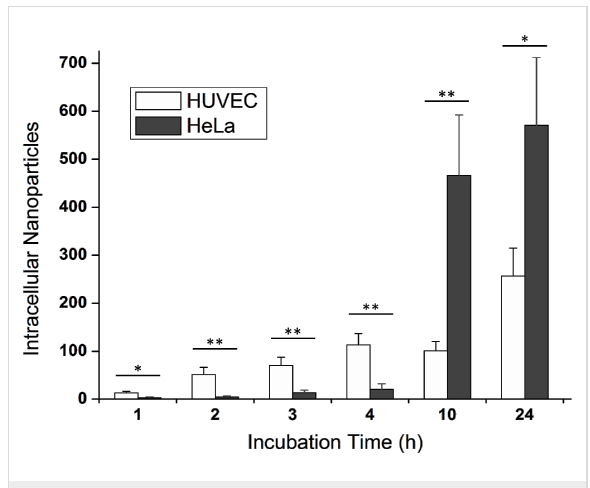
particles for HeLa cells was significantly larger than that for HUVEC